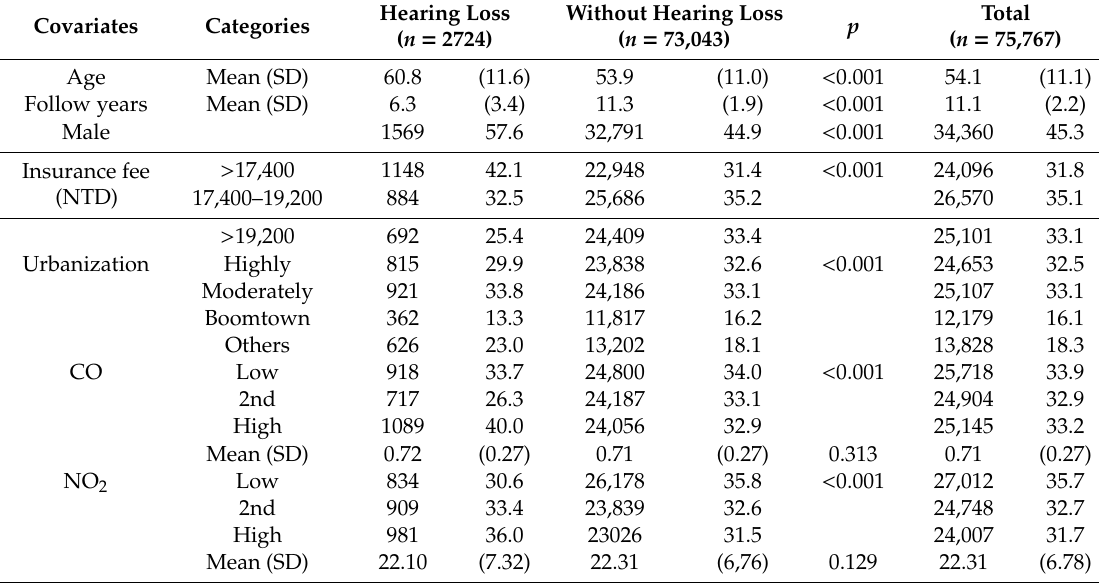
Table 1. Distribution of the demographic data of the study participants.